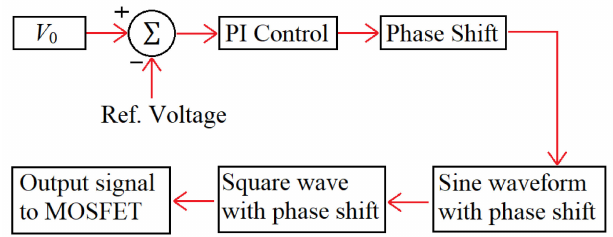
Figure 4. Flowchart of the output voltage closed-loop control.